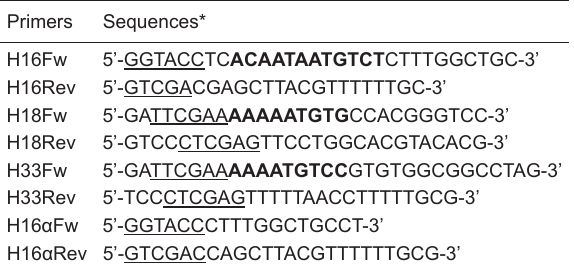
Table 1. Primers for amplification of the L1 gene of HPV-16, -18 and